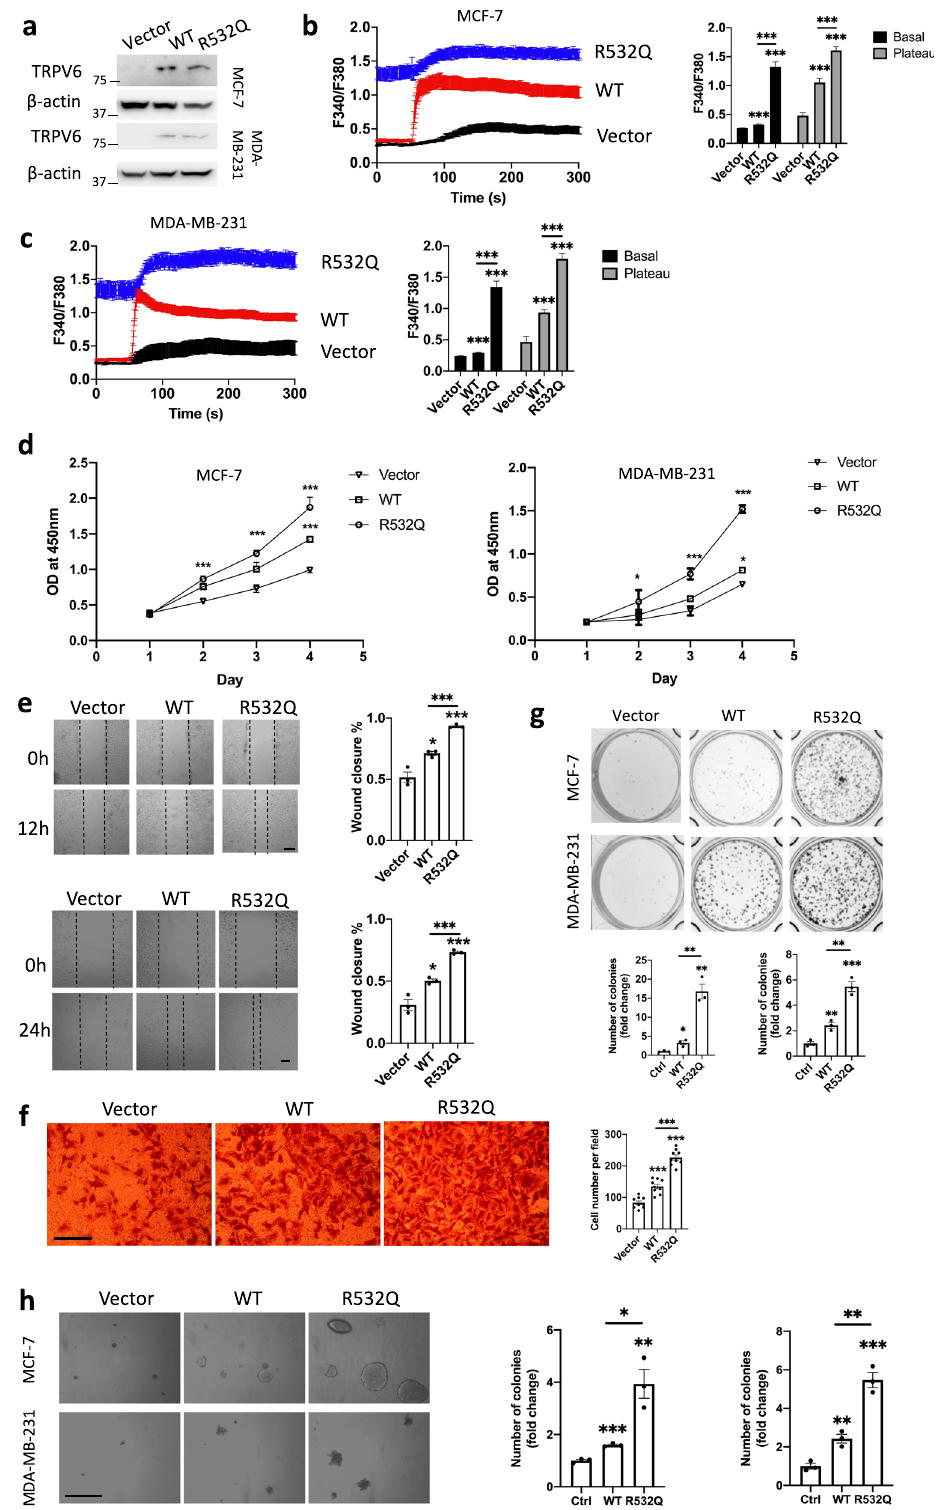
Effect of mutation R532Q on breast cancer cell progression . The expression of transfected WT TRPV6 and mutant R532Q in both MCF-7 and MDA-MB-231 cell lines was con fi rmed by western blotting (WB) (Fig. 4a), with endogenous TRPV6 detect- able through immunoprecipitation followed by immunoblotting 18 . of the TRPV6 channel function on breast cancer cell growth.